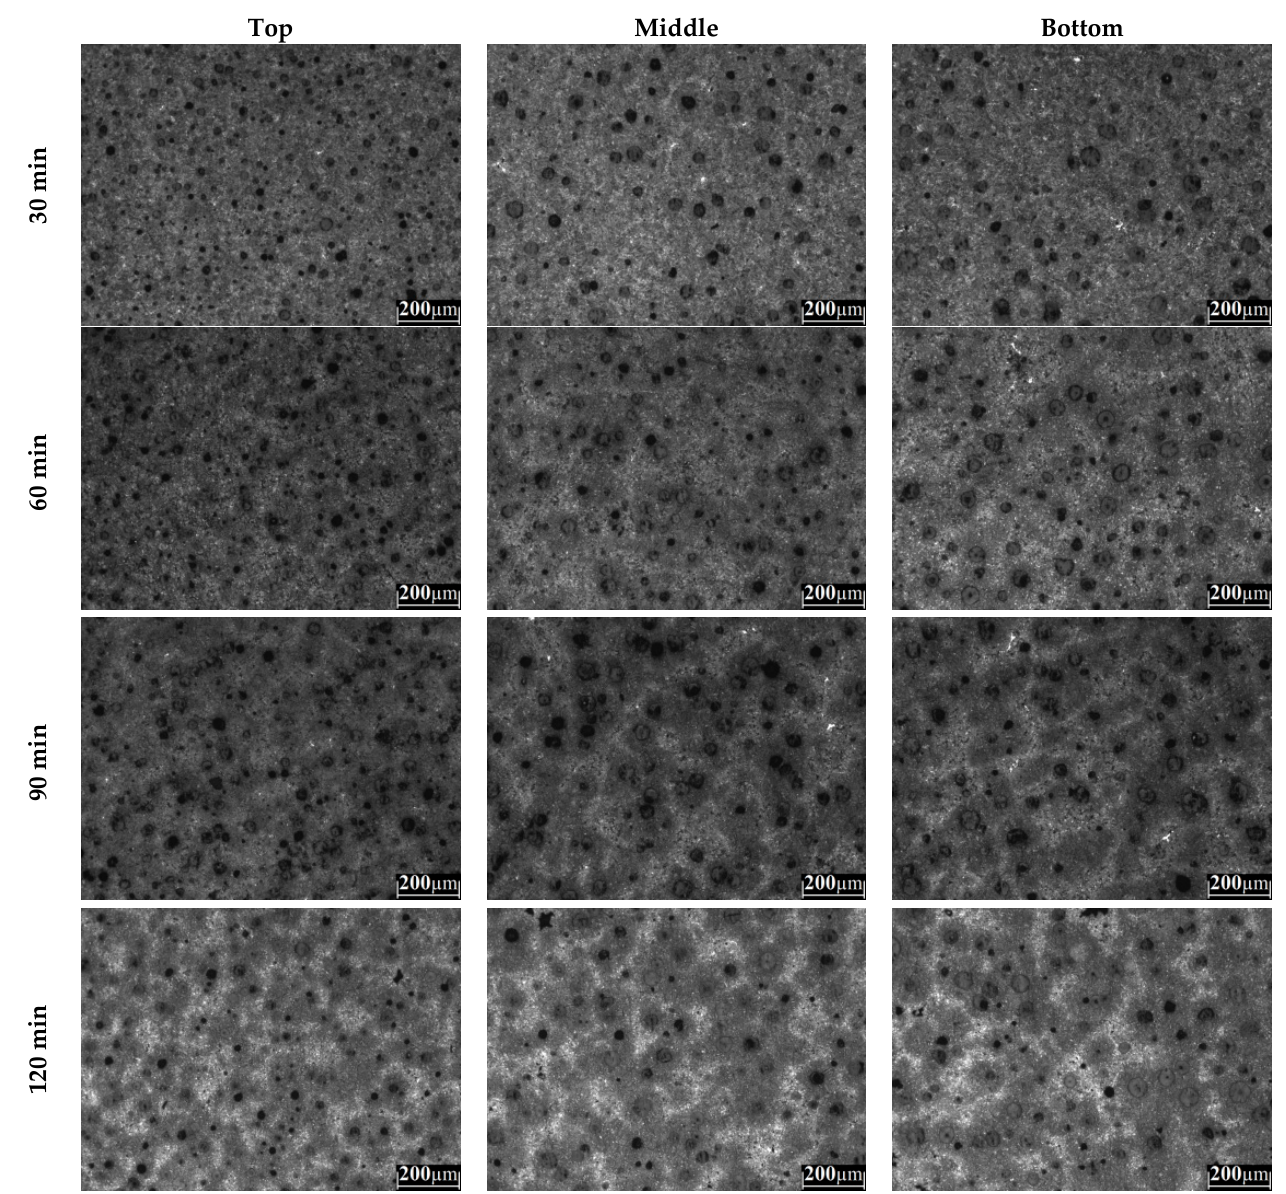
Figure A1. Microstructural evolution for the ADI ‐ 0.3V ‐ 265 sample at the austempering times of 30, 60, 90, and 120 min. Top Middle Bottom